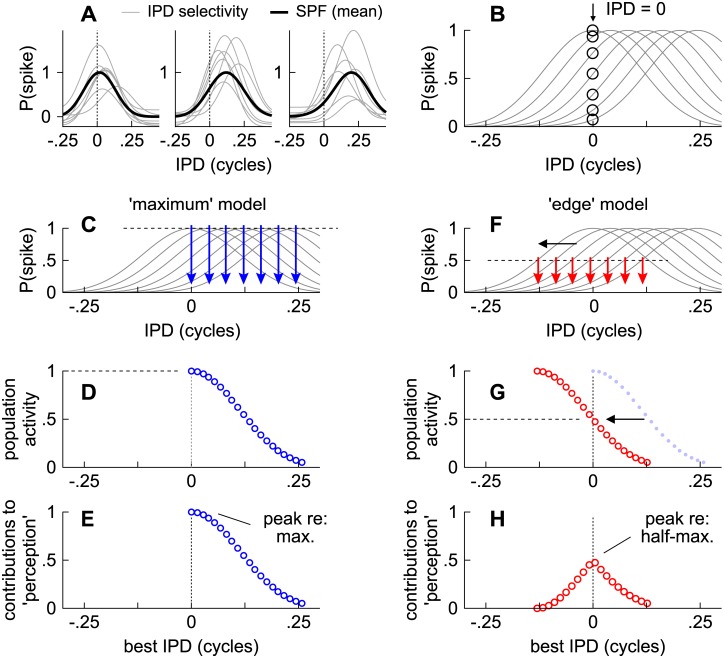
Description of the edge model.(A) Thick black lines show three different spike probability functions (SPF), each reflecting the average preference of a subpopulation of integrated neurons (thin gray lines). (B) Hypothetical array of SPFs in the left IC (thin lines). Open circles indicate the probabilities of spiking across the SPFs when the stimulus’ IPD is 0 cycles. (C) Array of SPFs in which downward arrows indicate the IPD at each SPF’s maximum. (D) Probability of spiking across as array of SPFs, where the abscissa indicates the IPD at each SPF’s maximum. (E) Contributions to perception from an activity maximum centered at an IPD of 0 cycles. (F) Array of SPFs in which downward arrows indicate the IPD at each SPF’s half-maximum. (G) Probability of spiking across as array of SPFs, where the abscissa indicates the IPD at each SPF’s half-maximum. (H) Contributions to perception from an activity half-maximum centered at an IPD of 0 cycles.